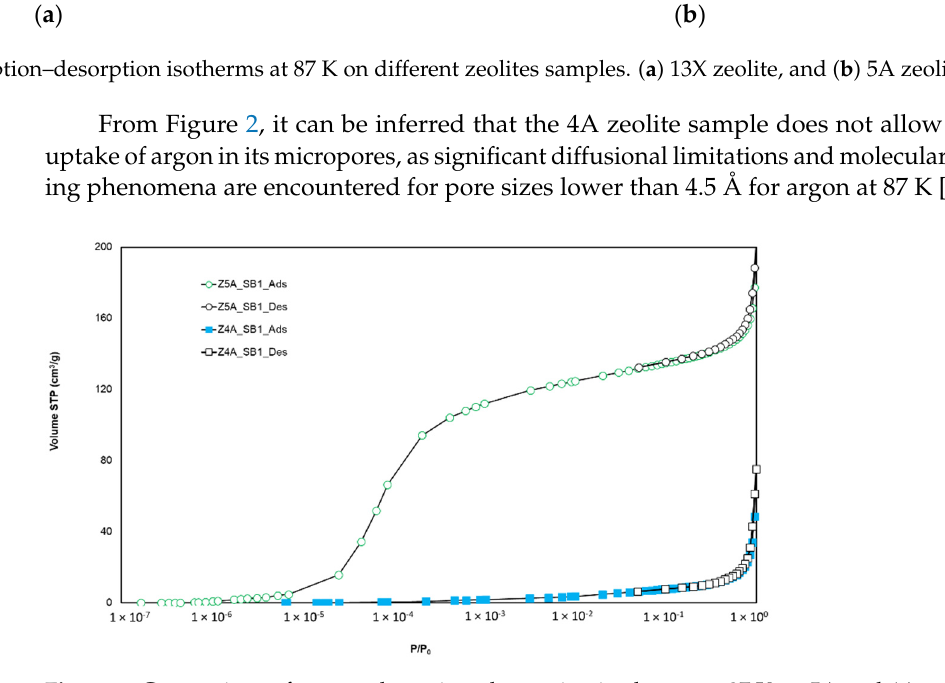
Figure 2. Comparison of argon adsorption–desorption isotherms at 87 K on 5A and 4A zeolites in spherical bed shape.